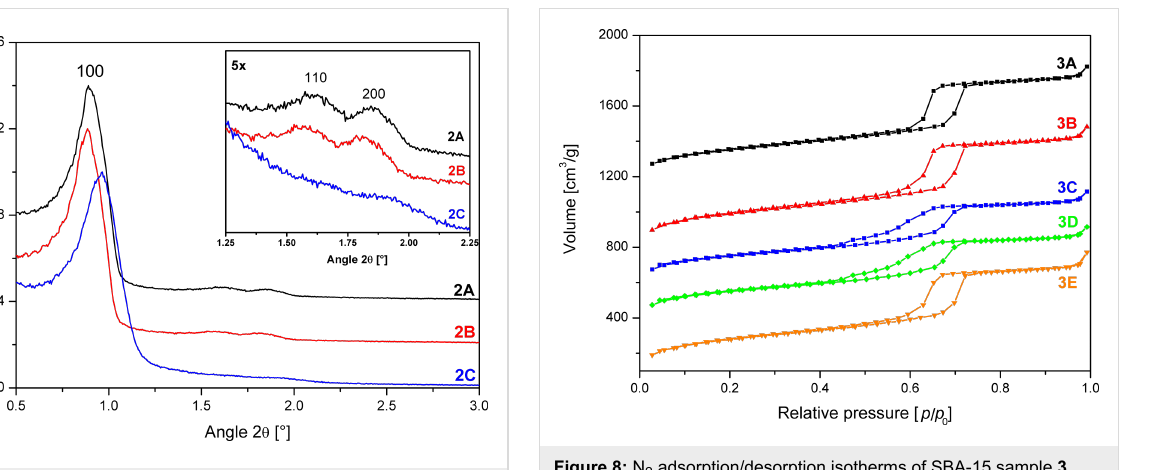
Figure 7: Small angle XRD of SBA-15 unwashed ( 2A ), after washing with 5 mL ( 2B ) and 30 mL ( 2C ) quantities of solvent. The intensities are normalized to the (100) reflection and offset by 0.4 ( 2A ) and 0.2 ( 2B ).